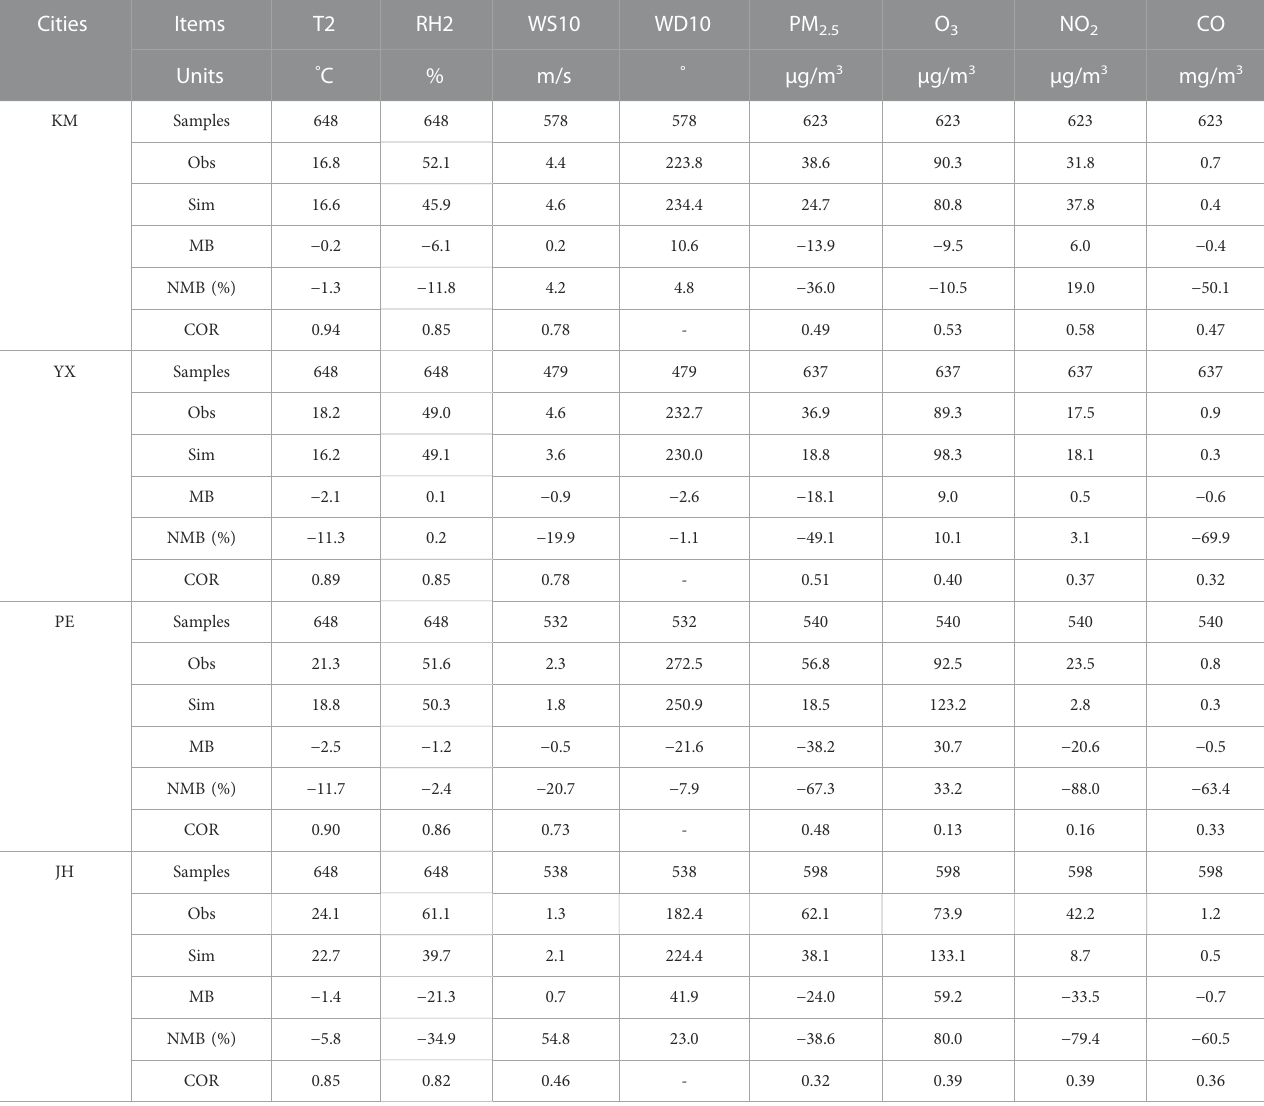
TABLE 2 Model performance statistics for meteorological variables and air pollutants in the 4 cities of Yunnan Province during the study period. Cities Items T2